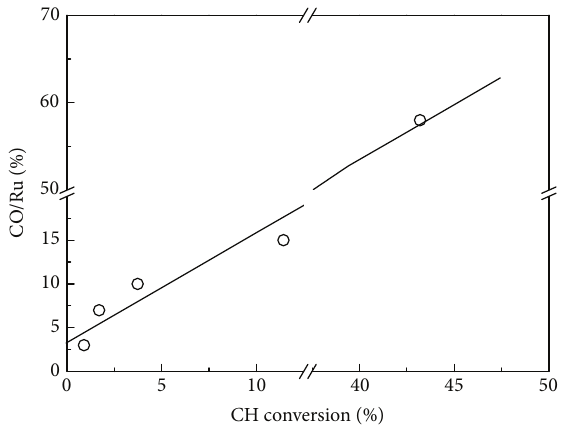
Figure 3: Linear relation between the CO/Ru ratio and the conver- sion of